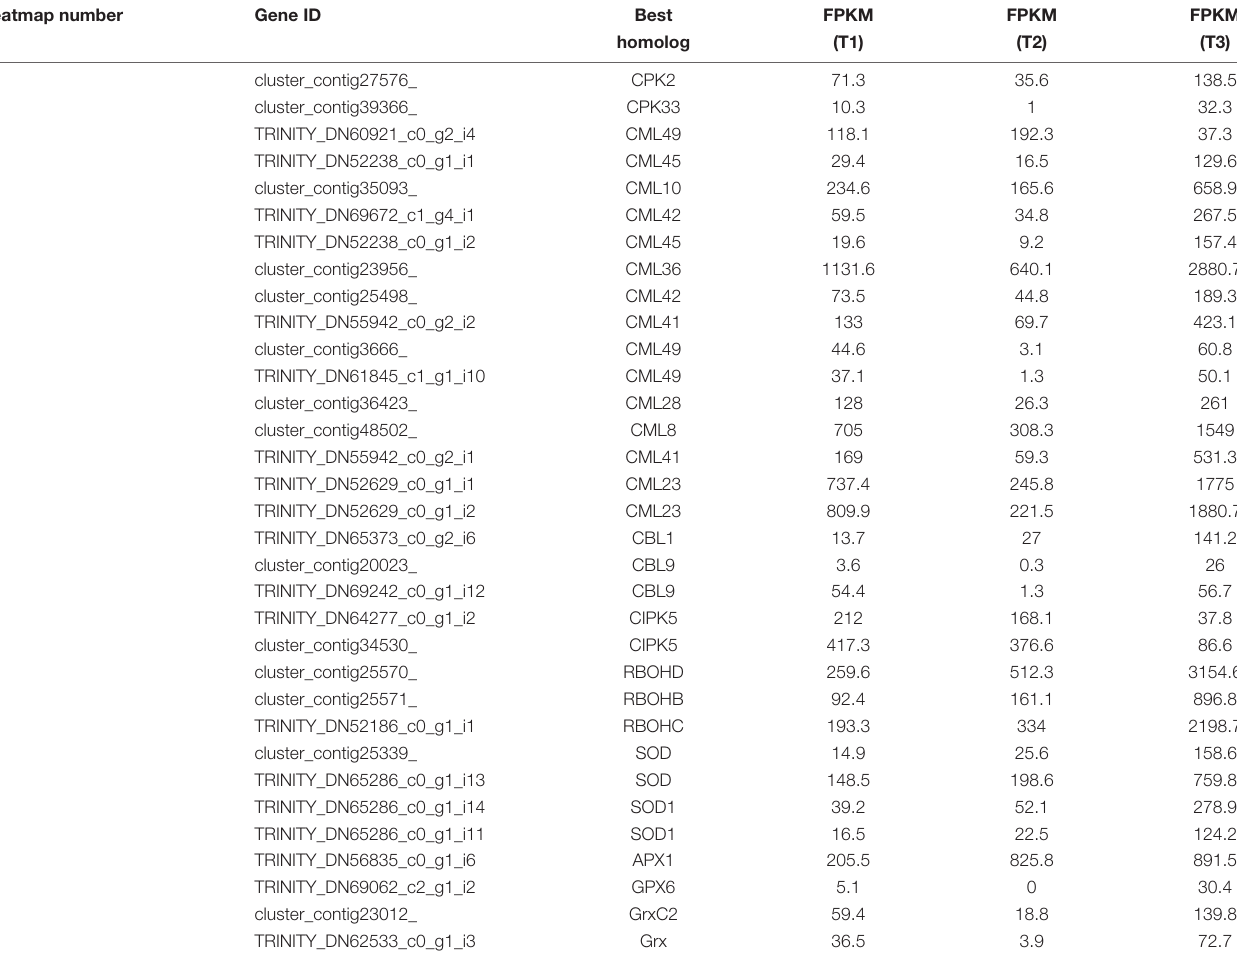
TABLE 1 | Ca 2 + signaling and ROS signaling (corresponding to Figure 3A ).